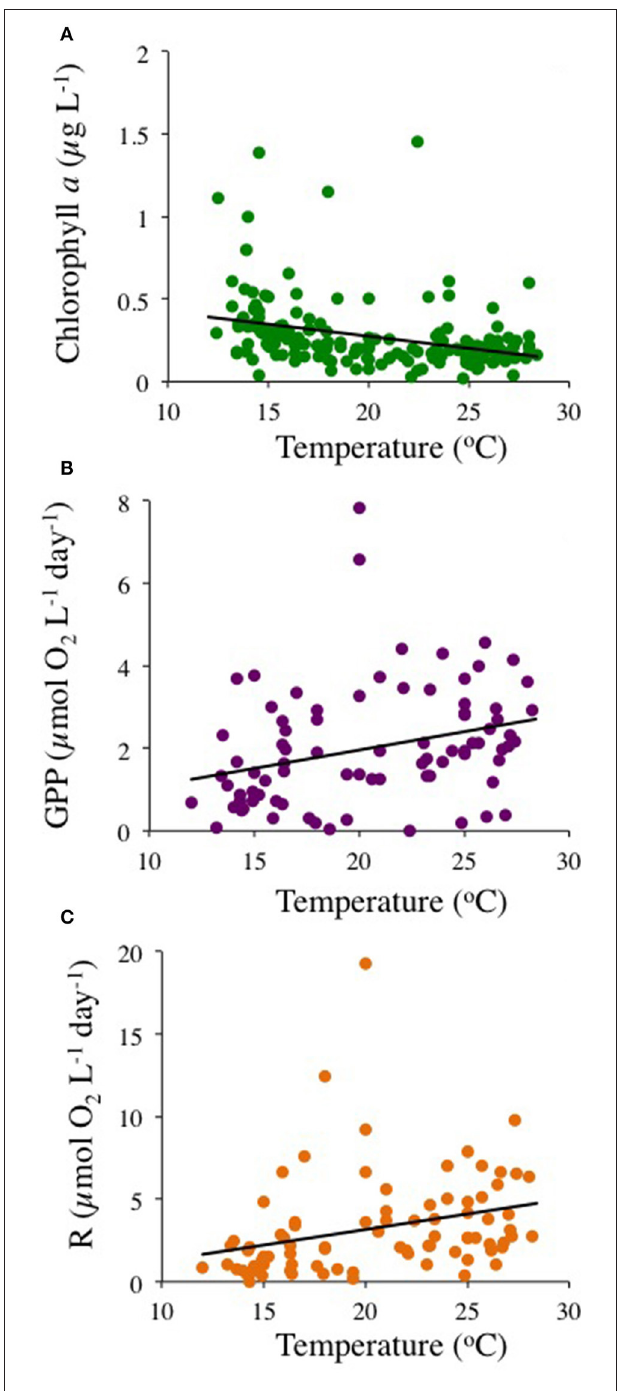
FIGURE 2 | The relationship between (A) Chlorophyll a ( P < 0.0001, green dots), (B) gross primary production ( P < 0.013, purple dots), and (C) community respiration rates ( P < 0.0001, orange dots), with